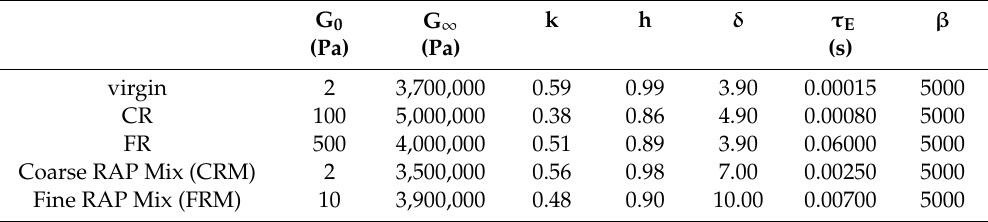
Table 2. The 2S2P1D model constants for all recovered Table 2. the 2S2P1D model constants for all recovered binder .